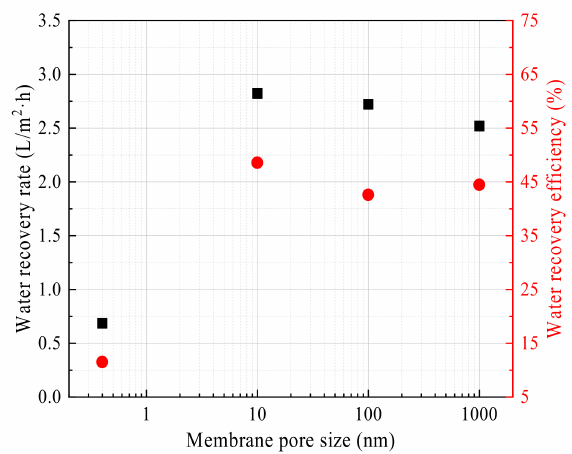
Figure 17. Water recovery rate/efficiency vs. Membrane pore size. Experiment conditions: flue gas inlet temperature 56.27 ◦ C, flue gas flow 10.58 L/min, negative pressure airflow 0 L/min.